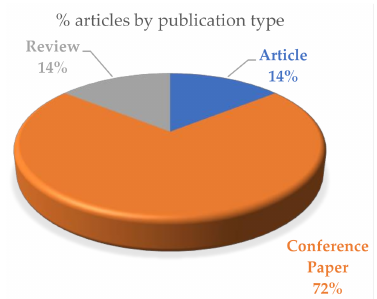
Figure 4. % Articles by publication